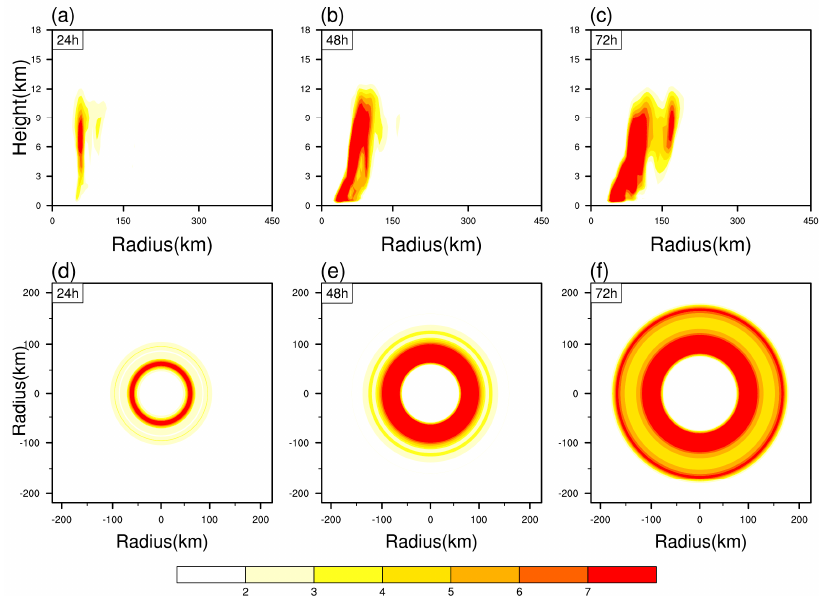
Figure 9. Height-radial cross-sections of azimuthal-mean diabatic heating (10 − 3 K s − 1 ) at ( a ) hour 24, ( b ) hour 48, and ( c ) hour 72. Horizontal distributions of the azimuthal-mean diabatic heating field averaged between 6 km to 8 km at ( d ) hour 24, ( e ) hour 48, and ( f ) hour 72, respectively.